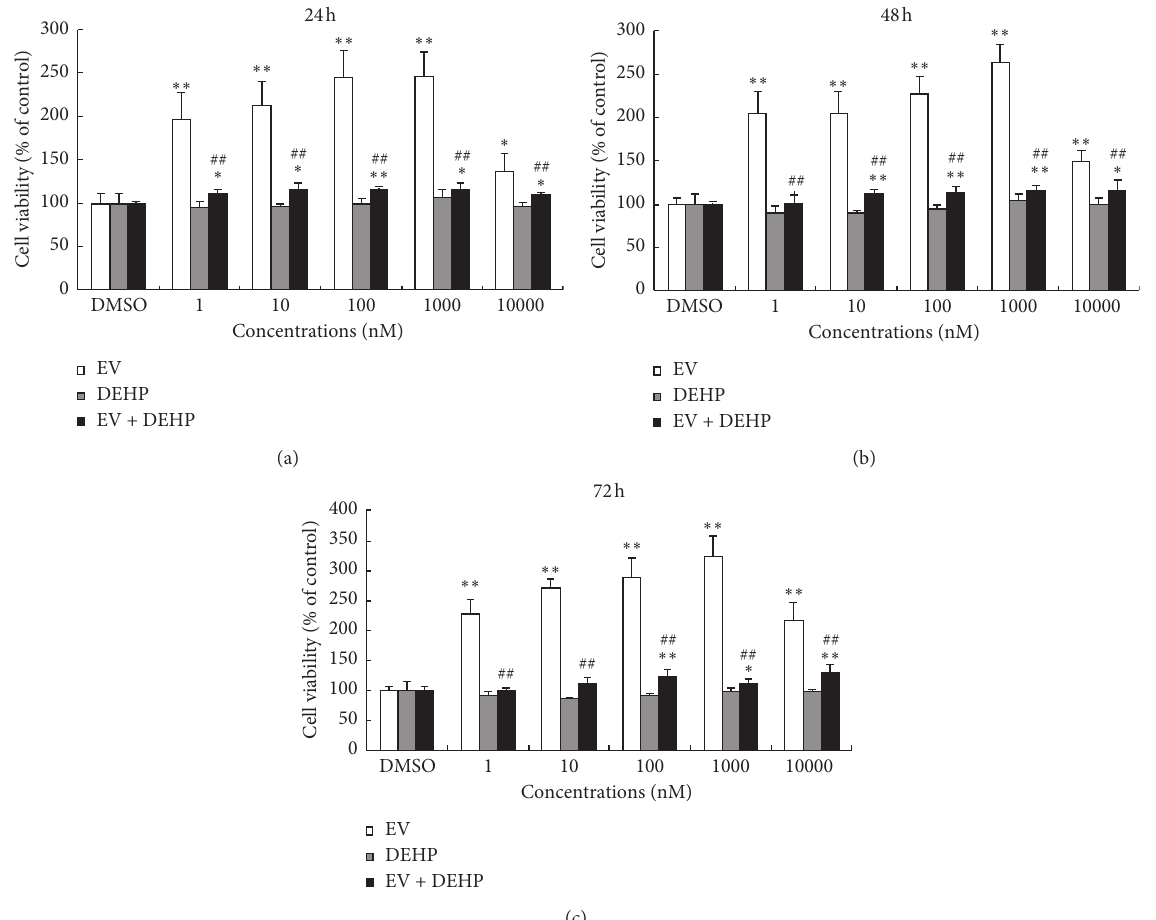
Figure 4: The binary joint effects of EV and DEHP on cell viability of MCF-7 cells. Exposure time: (a) 24h; (b) 48h; (c) 72h. Data points represent mean ± SD of three independent experiments with six replications. ∗ p < 0 . 05, ∗∗ p < 0 . 01, compared with DMSO; ## p < 0 . 01, compared with EV